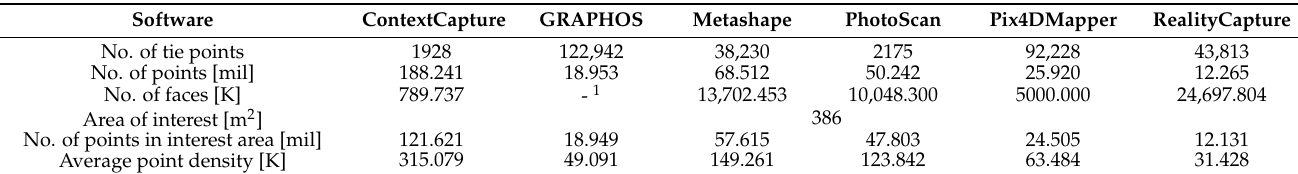
Table 3. Characteristics of generated products in used